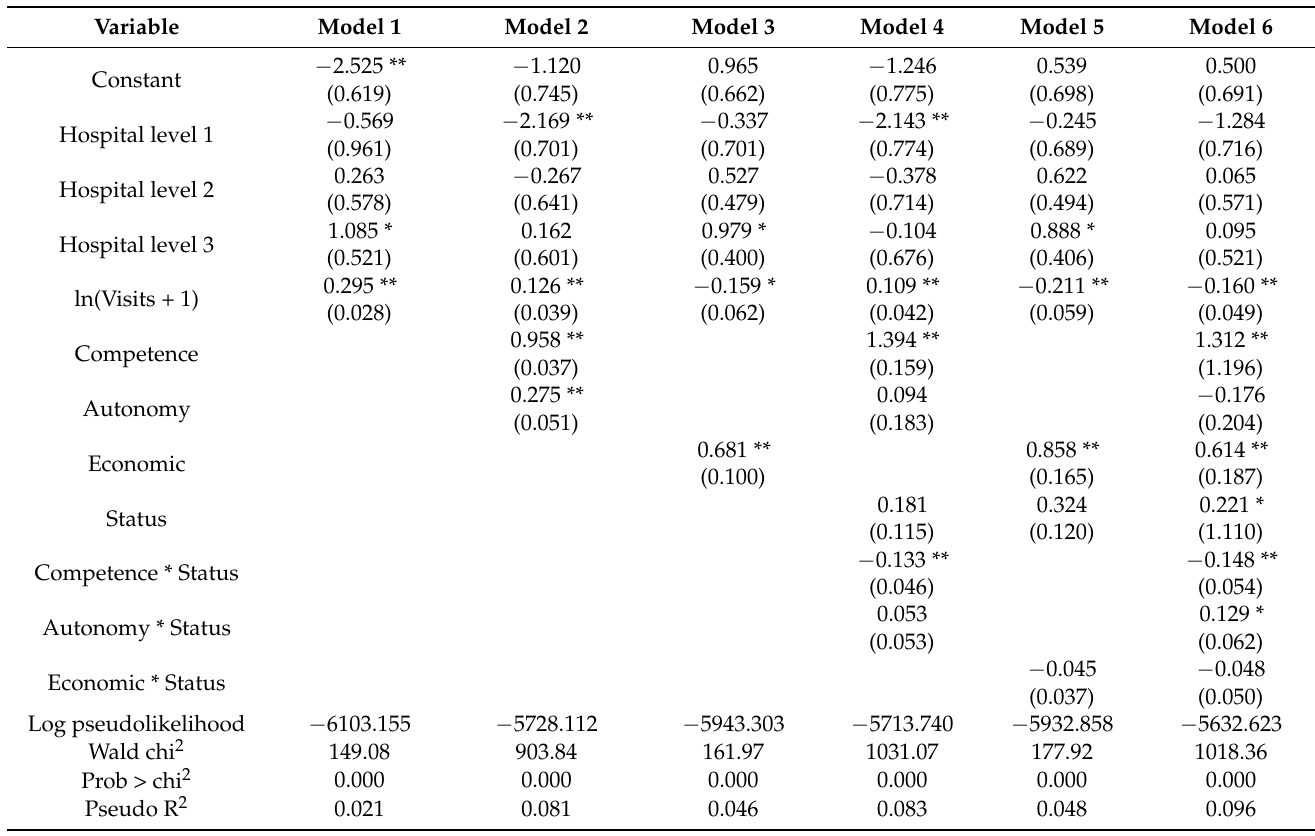
Table A1. Parameter estimates of negative binominal regression ( n = 2702).